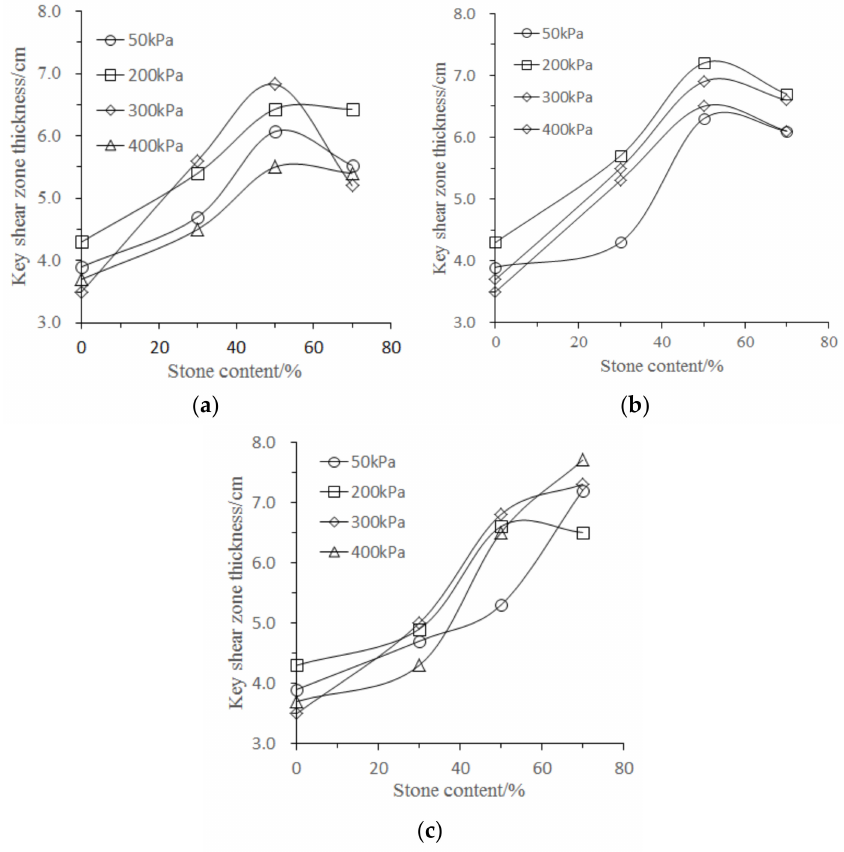
Figure 15. E ff ect of stone content on the key shear zone thickness. ( a ) Stone size L 1; ( b ) stone size L 2; ( c ) stone size L 3.